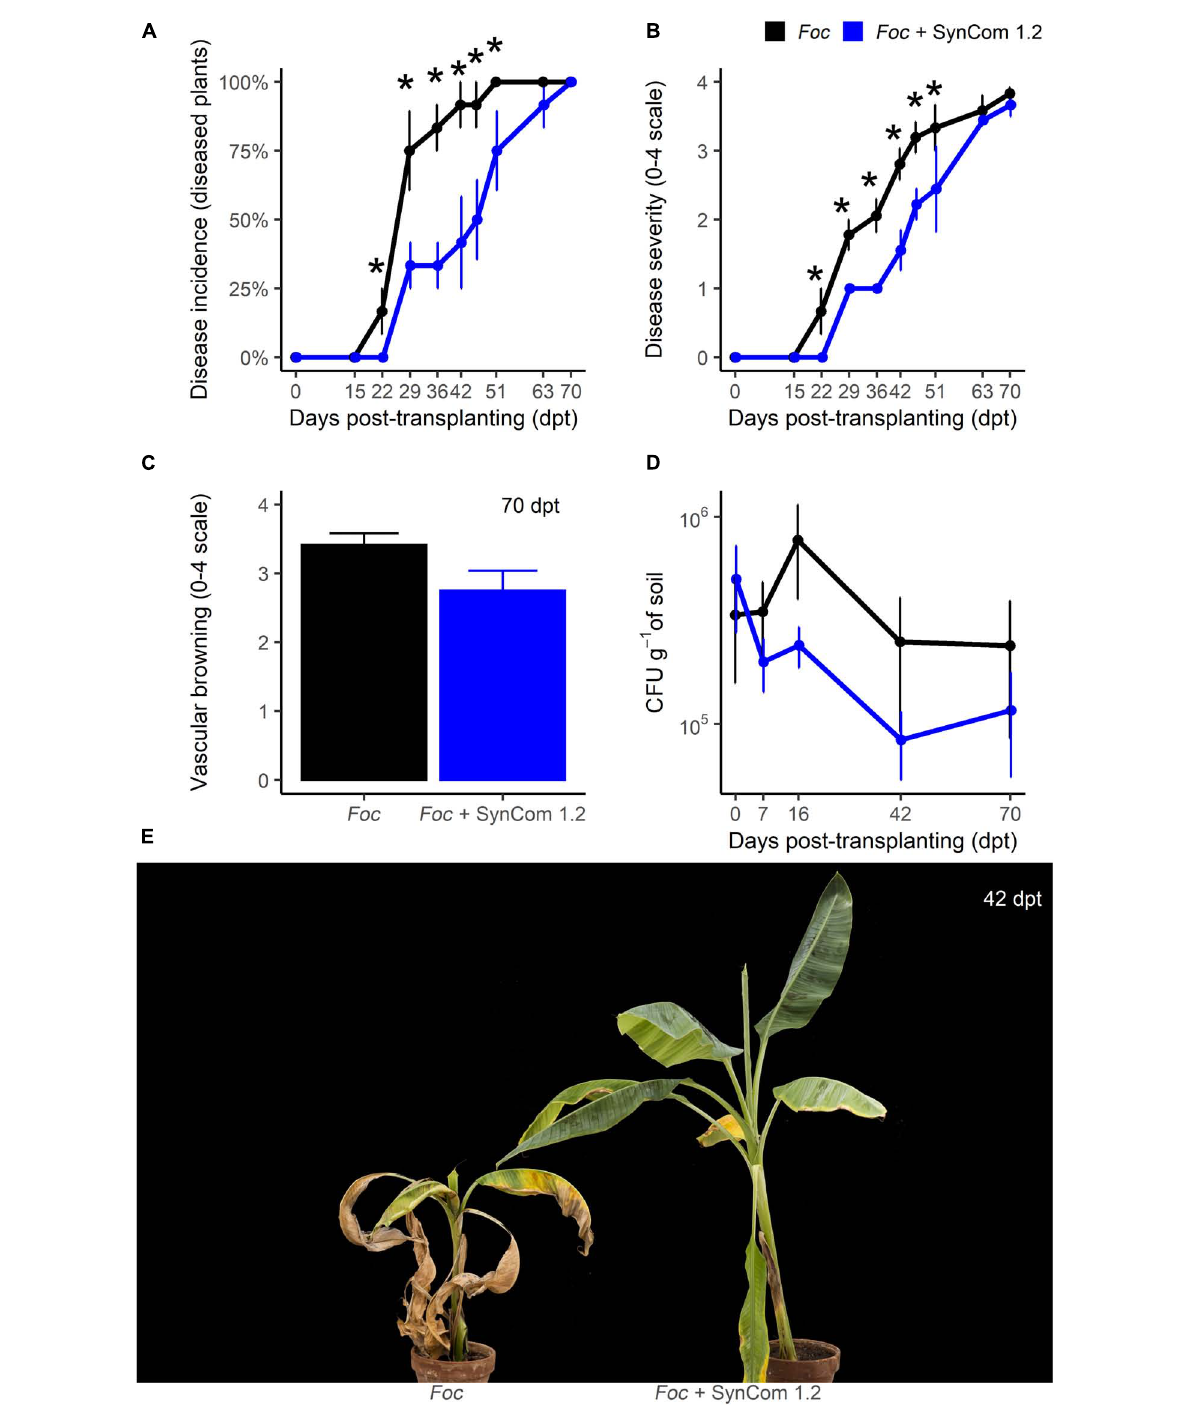
FIGURE7 Biocontrol trial C: SynCom 1.2. Banana plants ‘Gran Enana’ were grown in steam-sterilized soil inoculated with 5.10 5 CFU g − 1 soil of Fusarium oxysporum f. sp. cubense tropical race 4, alone or in combination with the synthetic microbial community SynCom 1.2. Fusarium wilt incidence (A) , symptom severity (B) , vascular browning (C) , and Fusarium spp. soil population (D) were measured to assess the biocontrol effectiveness of SynCom 1.2. Symptoms occurring on treated and control plants are shown in (E) . Bars indicate standard error ( n = 3 in A,D , while n = 15 in B,C ). Asterisks indicate significant differences between treated and control plants according to Dunn’s test ( P <